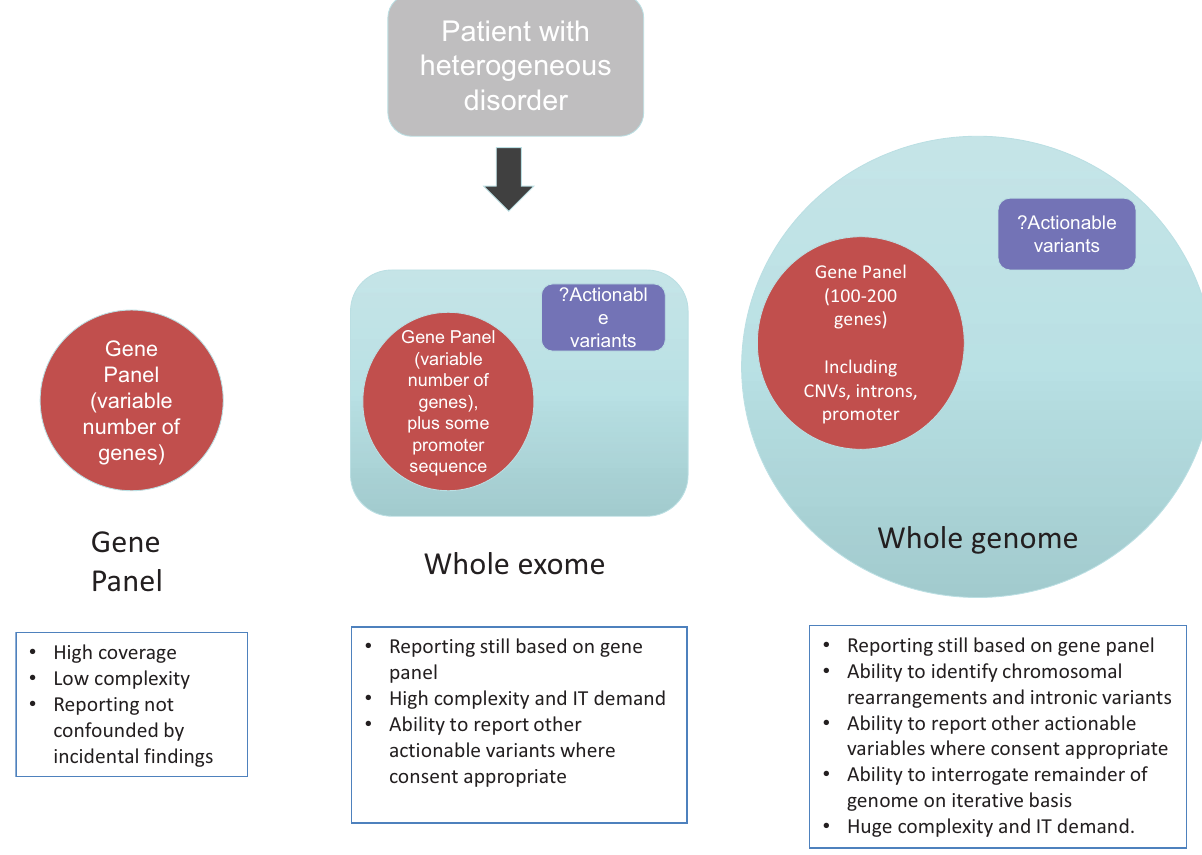
Figure 3. Diagnostic approaches using next generation